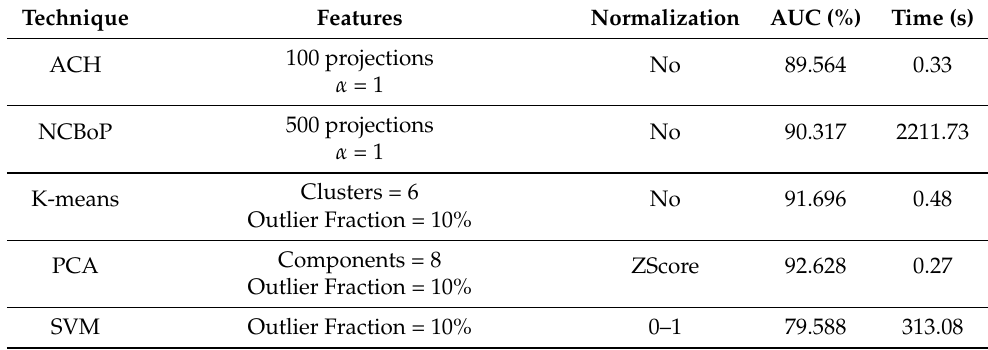
Table 2. Best AUC results for MiTM attack for each